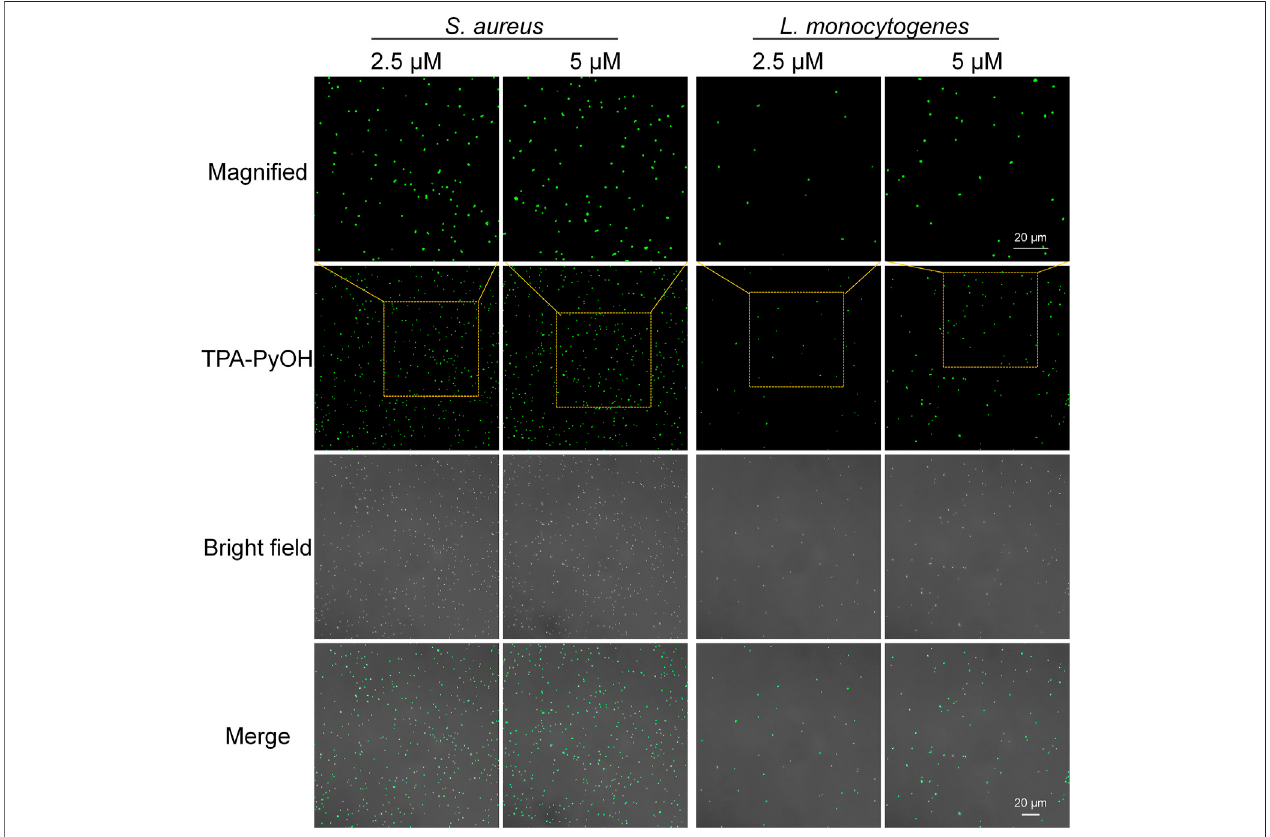
FIGURE3| CLSMimages(40 × )of S.aureus and L.monocytogenes afterstainingwithTPA-PyOHatdiversecontentfor5 min.TPA-PyOHwasexcitedat488 nm, and the emission range was collected at 520 – 670 nm. Green pseudo color is used to represent fl uorescent signal from TPA-PyOH